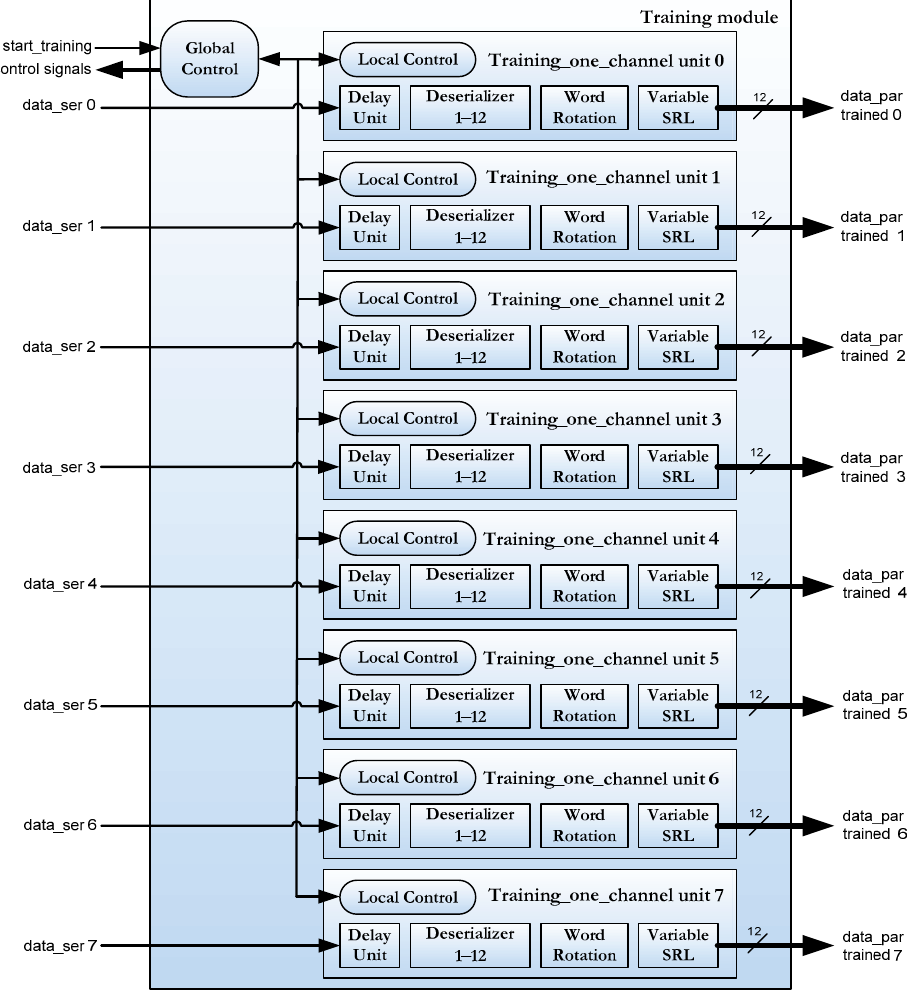
Figure 14. Block diagram of the concurrent channel calibration for the training